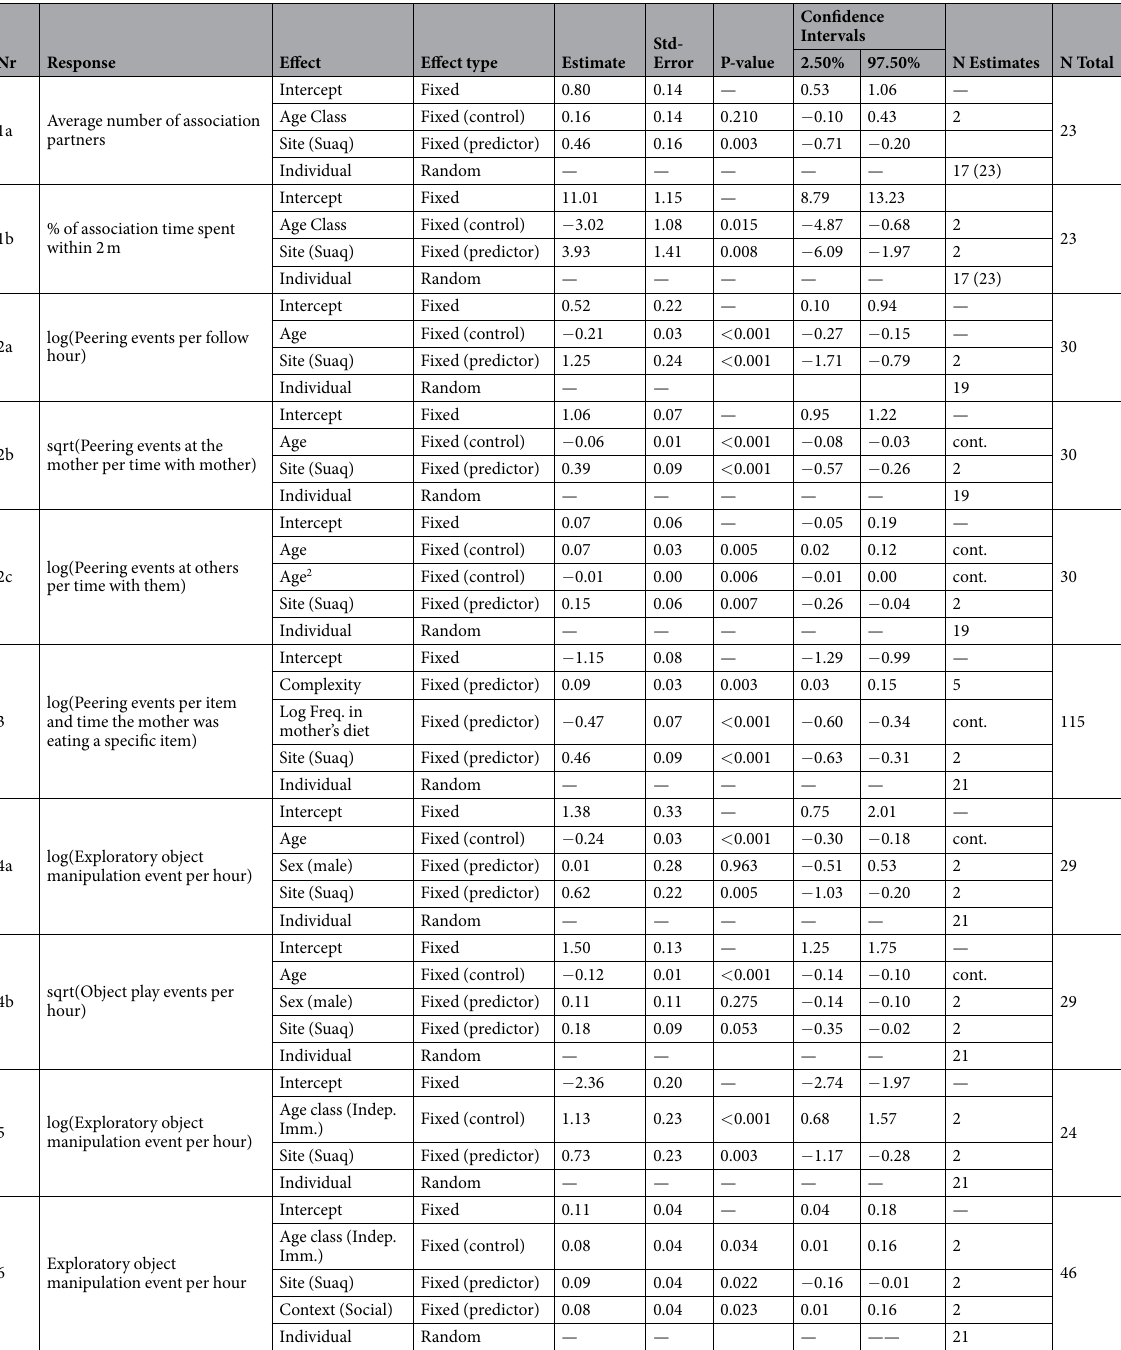
Table 2. Linear mixed efect models with response variables, fixed effects and random effects: estimates, standard errors, * P-values, 95% confidence intervals, number of levels for the categorical variables (N Estimate) and total sample size of the model (N Total). * P-values were calculated via the likelihood ratio test by excluding the specific factor and comparing the reduced model to the full model. 1: Average association time with individuals other than the mother or the semi- dependent sibling (a) and percent of association time spent within wo meters of adult association partners other than the mother (b) as response variable. The factor “Age class” refers to the two classes of dependent immatures: 0–2.9 y and 3–6 y. 2 c: Peering events at individuals other than the mother per hour spent in association with at least one of those individuals as response variable. 3: Peering rate as response variable (number of peering events per item and time the mother was eating a specific food item), number of pre- ingestion processing steps of the food item (“Complexity”), frequency of the food item in the mothers diet (log transformed; “Frequency”) as effects. The N model here represents the total number of individual - age - food item combinations. 5: The effect “Age class” refers to independent immatures versus mothers. 6: The effect “Age class” refers to independent immatures versus mothers and “Context” to alone (solitary) versus social (with at least one association partner other than the own dependent or semi- dependent